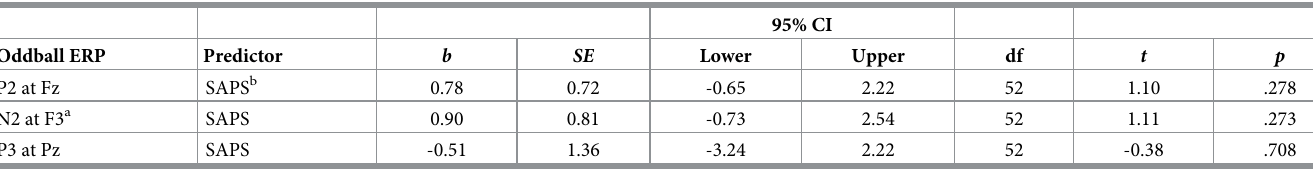
P2, N2, and P3 oddball effect as a function of individual differences in smartphone addiction. ERPs were time-locked to the presentation of the visual stimulus. a N2 is a negative going potential, thus smaller values indicate larger ERP amplitude.